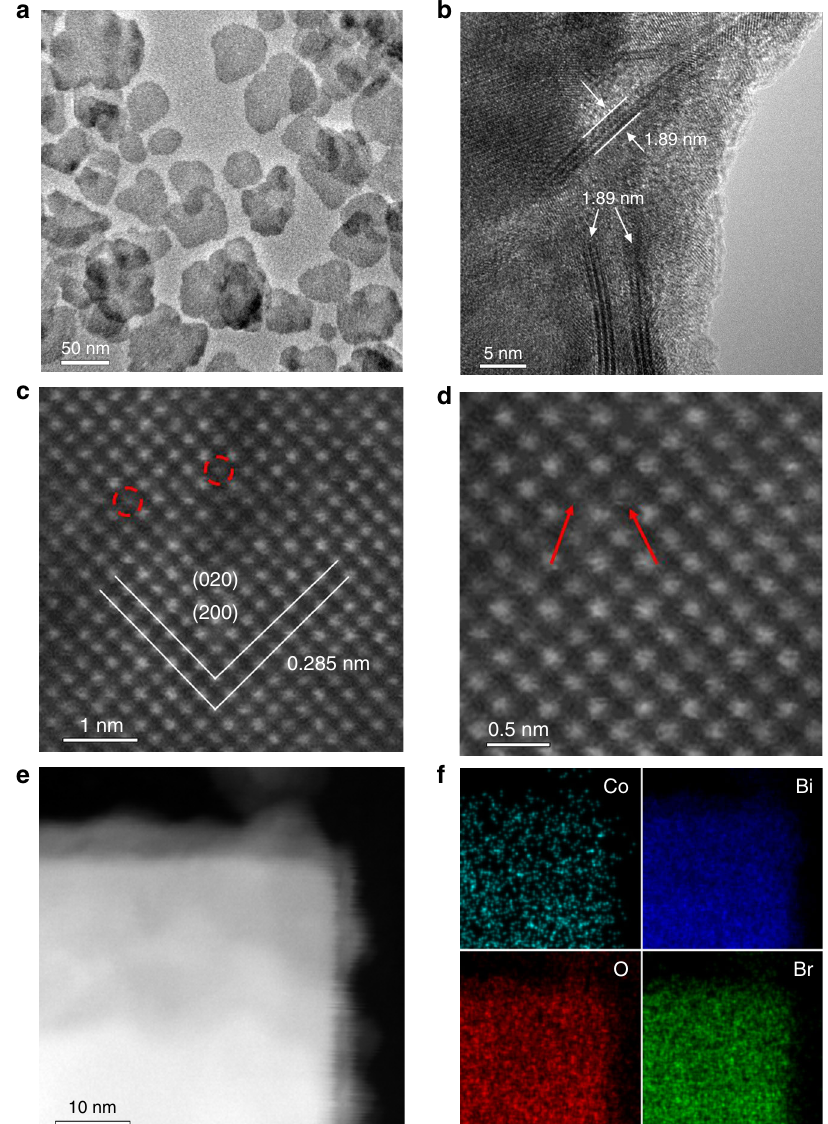
Fig. 1 Surface morphology of Co – Bi 3 O 4 Br-1. a , b TEM and c , d atomic resolution HAADF-STEM images of Co – Bi 3 O 4 Br-1, e , f STEM image and EDS mapping images of Co, Bi, O,